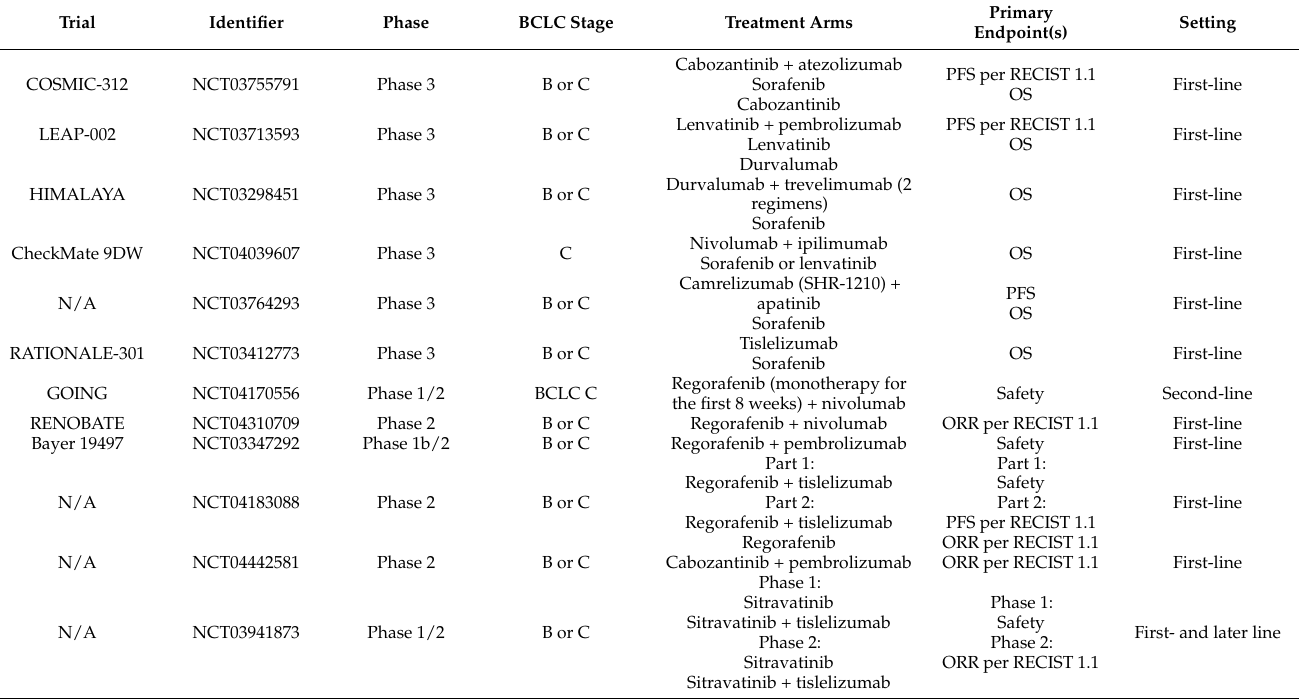
Table 2. Current clinicals trials on palliative systemic treatments in